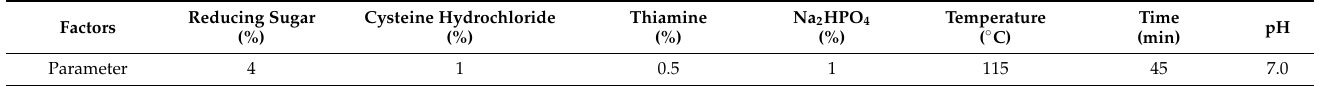
Table 1. Maillard reaction parameters of self-made